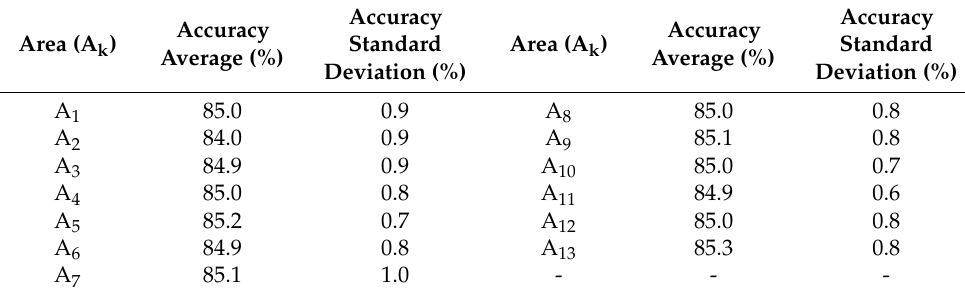
Table 4. Congestion Forecast Result (1 month period).